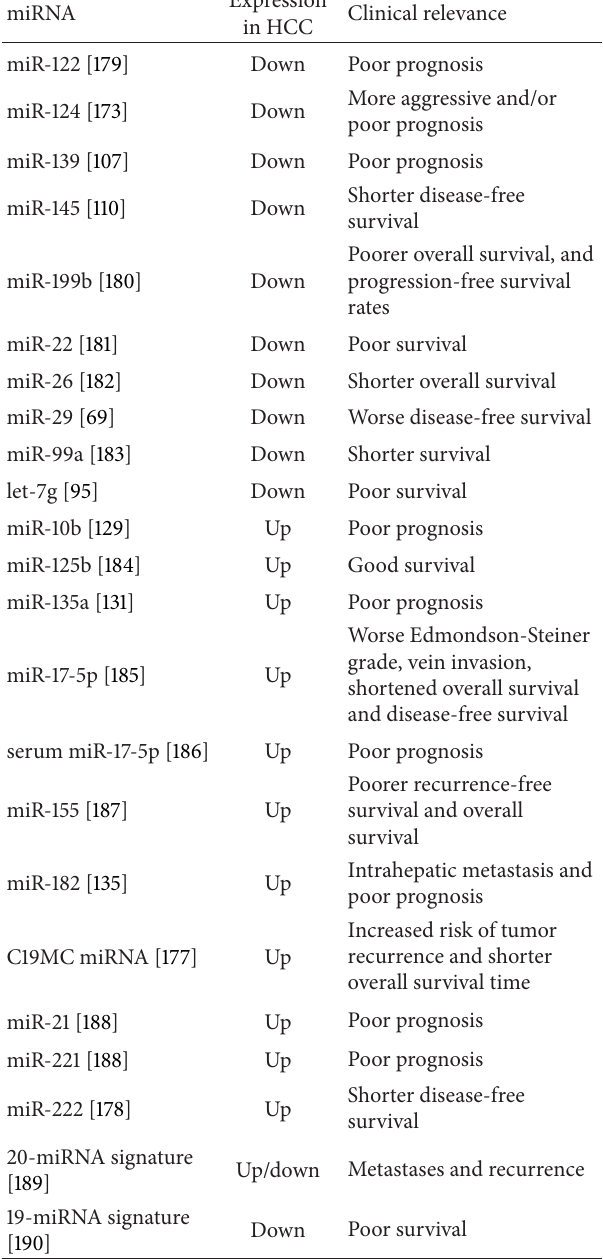
Table 3: Clinical relevance of deregulated microRNAs in